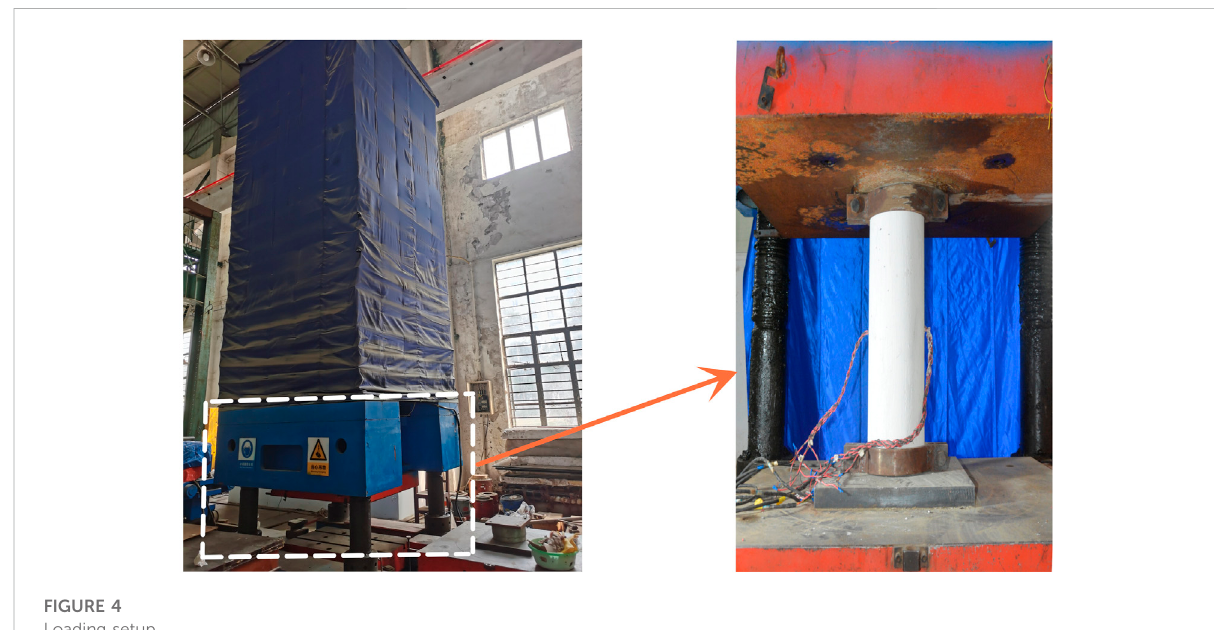
FIGURE 4 Loading